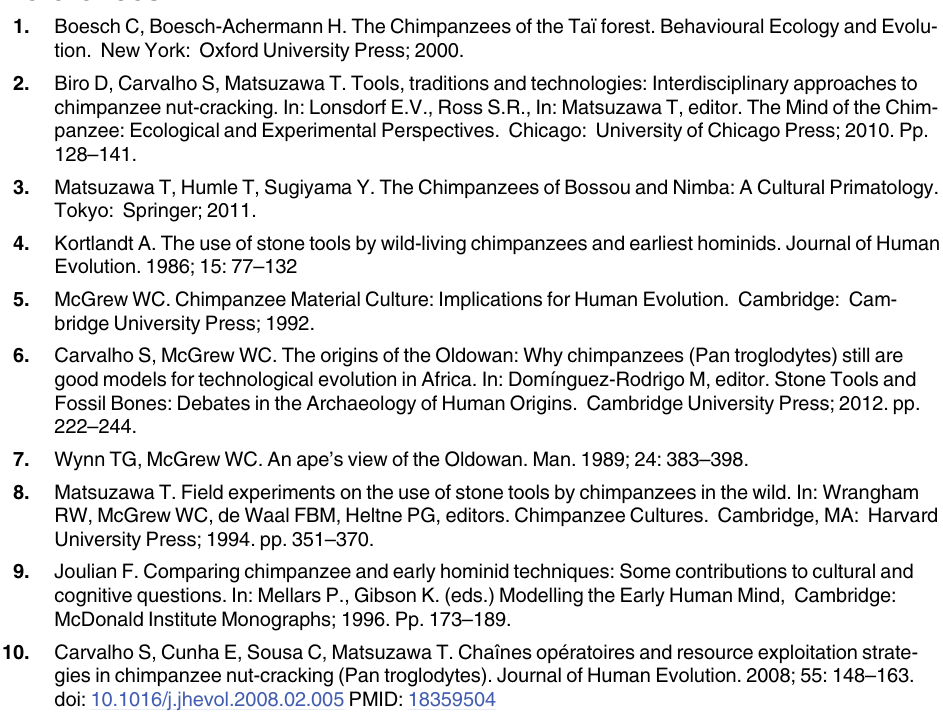
S2 Table. Curvature characteristics of depressions and ridges. Percentage of curvature clas- ses in the depressions and ridges for every stone tool face. S3 Table. DSM basic statistics in the depression and ridges of the stone tools. S4 Table. DSM basic statistics in the depression and ridges for every stone